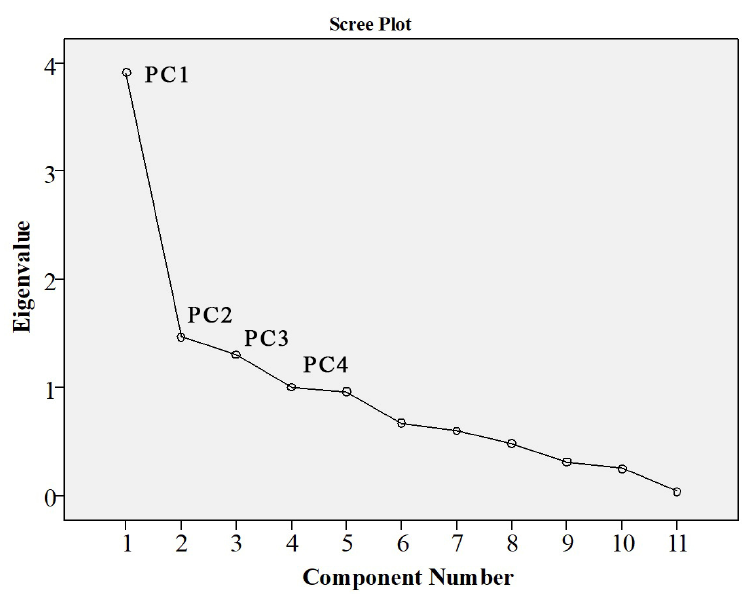
Figure 12. The Scree plot of WQPs .